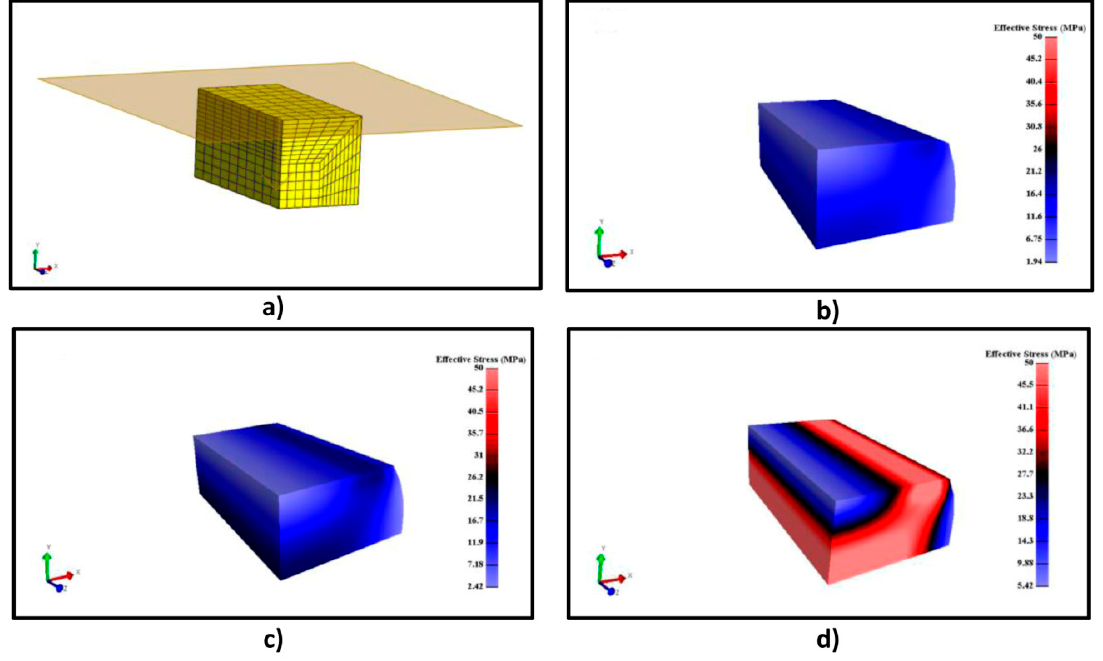
Figure 12. ( a ) Meshed geometry; ( b ) FEM simulation results for CA without GO; ( c ) FEM simulation results for CA with 3% GO; ( d ) FEM simulation results for CA with 9% GO.